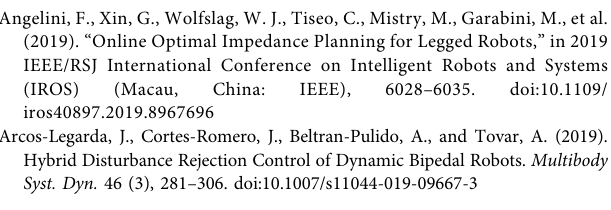
Frontiers in Robotics and AI |